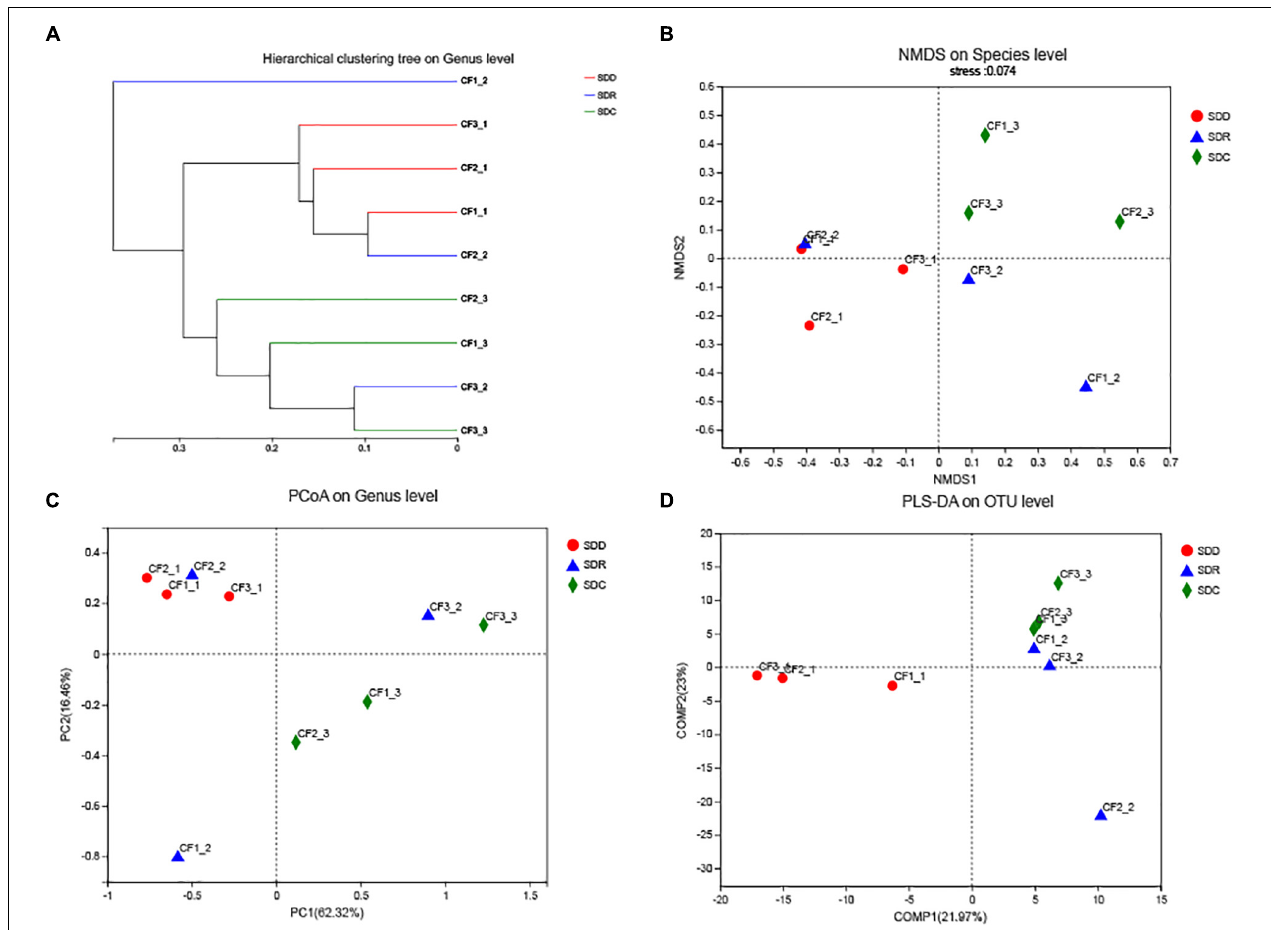
FIGURE 8 | Analysis of the beta diversity of the fungal community in groups based on processing methods. (A) Hierarchical clustering tree on genus level, (B) NMDS plot on species level, (C) PCoA plot on genus level, and (D) PLS-DA plot on OTU